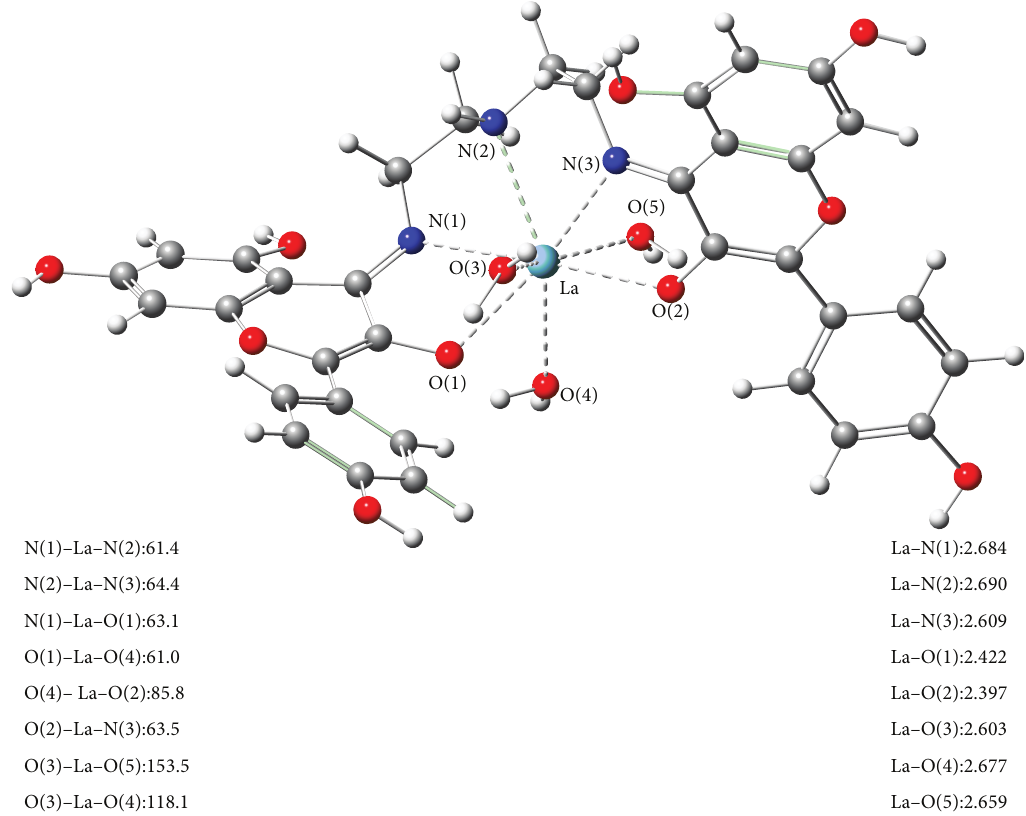
Figure 2: The optimized structure of the La (III) complex. The sky blue ball is for La atom, the red balls are for oxygen atoms, the blue balls are for nitrogen atoms, the gray balls for carbon atoms, and the white balls are for hydrogen atoms. Bond lengths are in angstrom and bond angles are in